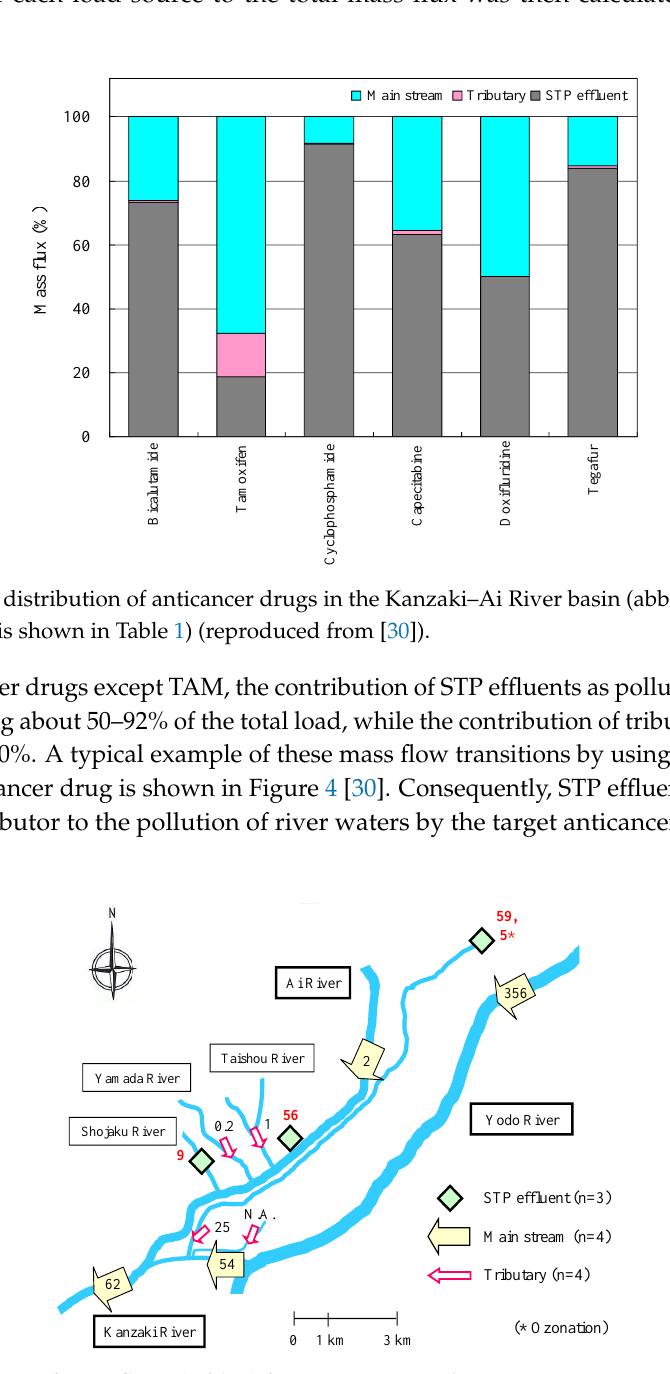
Figure 4. Transition of mass flows (g/day) from upstream to downstream regions in the Kanzaki–Ai River basin for bicalutamide (BLT). N.A.: not available (reproduced from [30]).